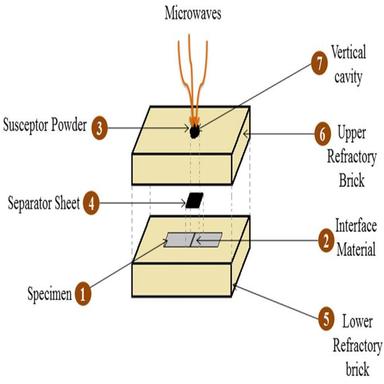
Schematic diagram of Selective Microwave Hybrid Heating .